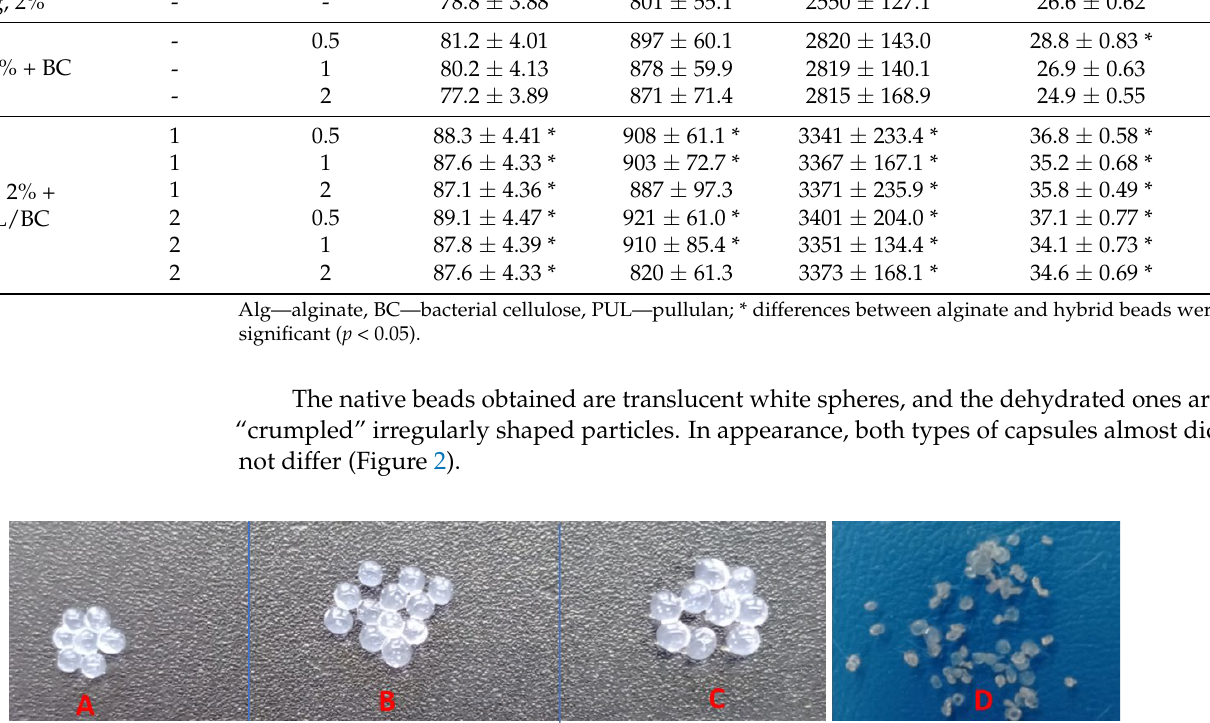
Figure 2. The appearance of beads: Alg ( A ), Alg/BC ( B ), Alg-PUL/BC ( C ), and dehydrated ( D )